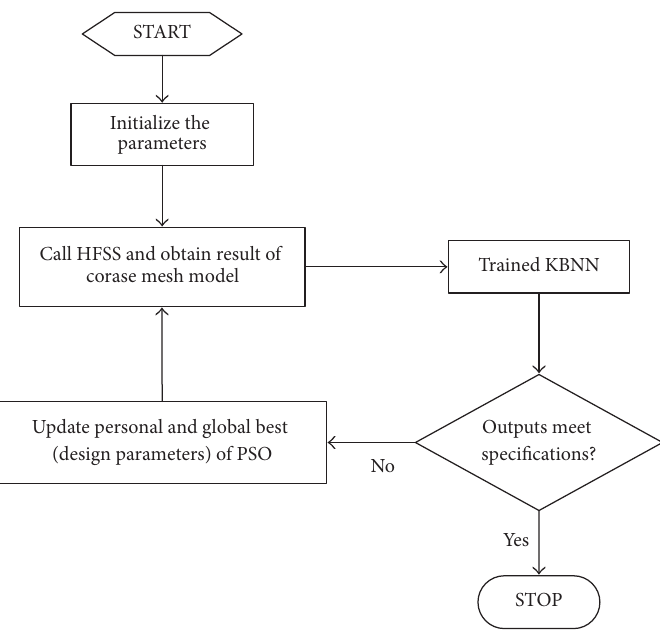
Figure 3: Flowchart of design optimization.